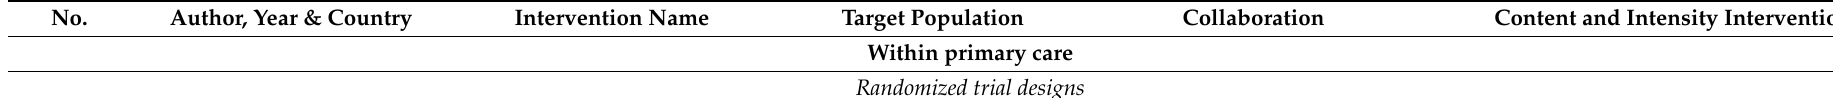
Table 2. Overview of included